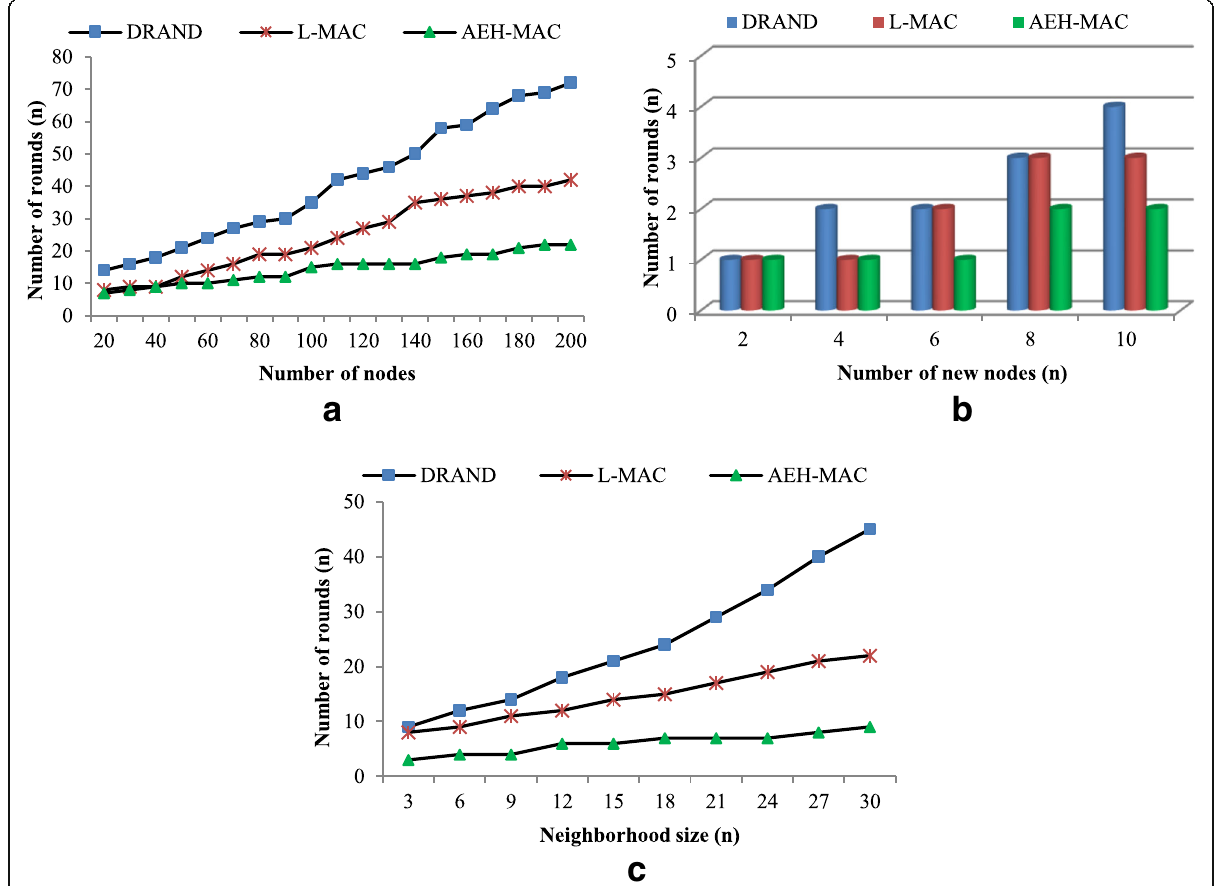
Fig. 11 Number of rounds to acquire a slot: ( a ) Nodes vs. Rounds ( b ) New nodes vs. Rounds ( c ) Neighborhood size vs.